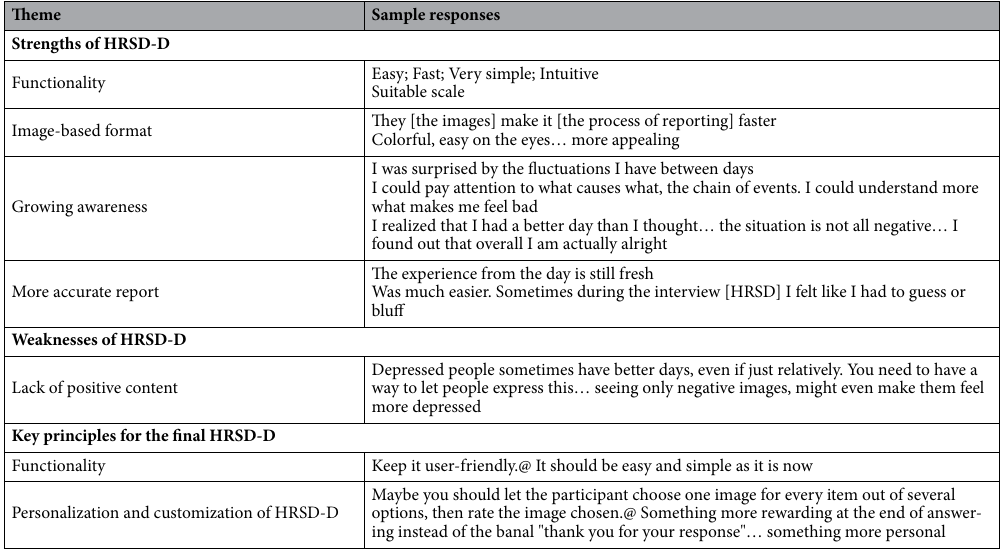
Table 8. Summary of themes and sample responses extracted from participants’